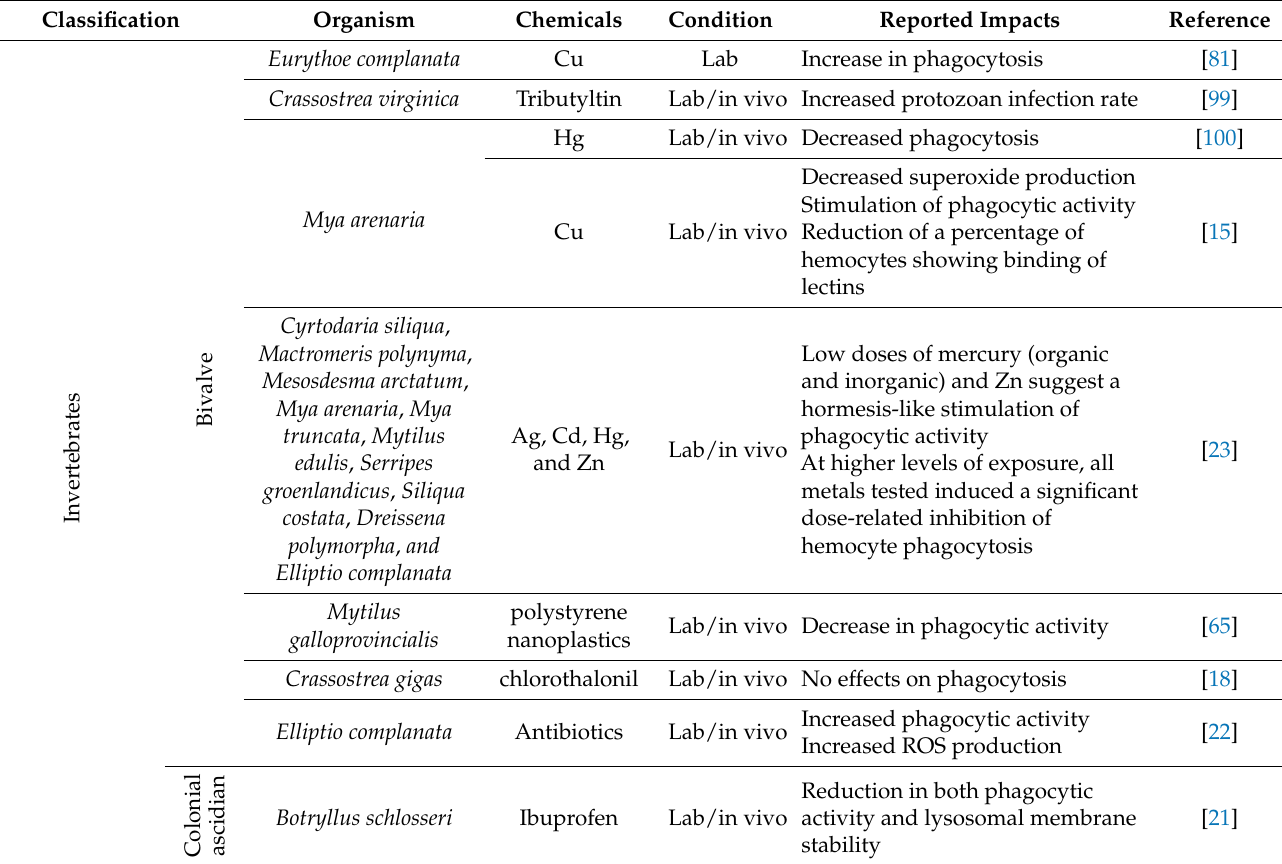
Table 1. Chemical substances that have been reported to have immunotoxic effects in invertebrates (bivalves and colonial